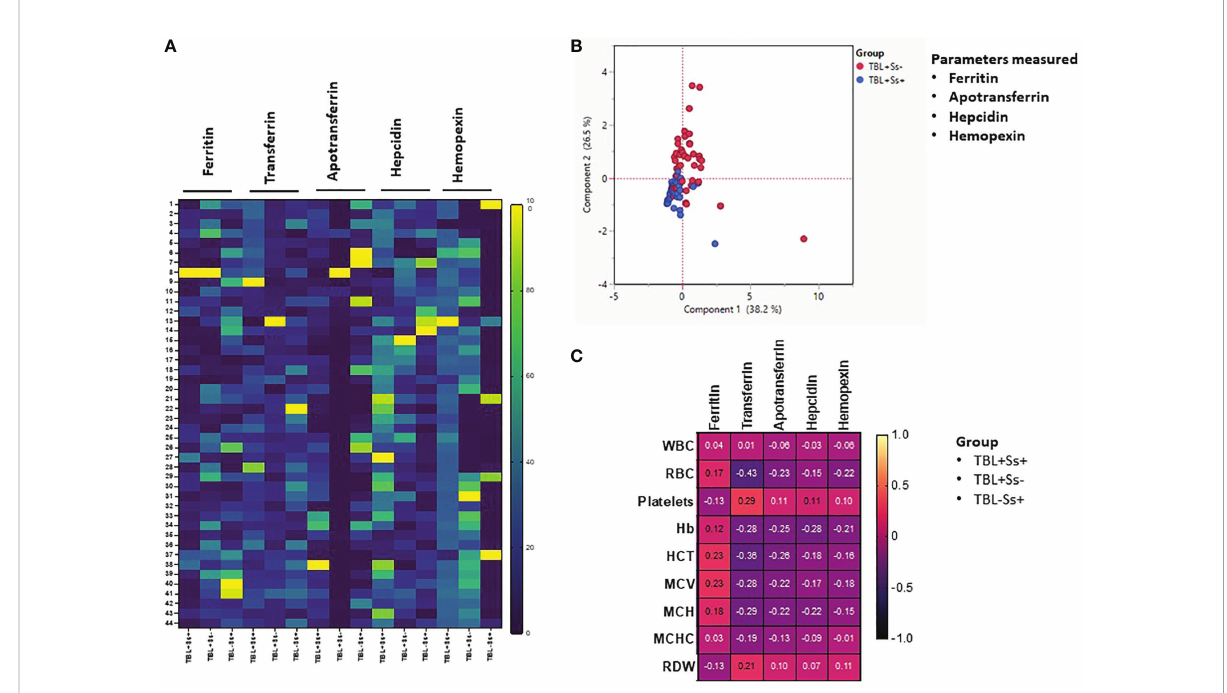
FIGURE 3 Heatmap, principal component analysis (PCA) and correlation analysis of iron status biomarkers. (A) Heatmap analysis of iron status (ferritin, TF, ApoT, hepcidin, hemopexin) biomarkers was performed between TBL+Ss+ (n=44), TBL+Ss- (n=44) and TBL-Ss+ (n=44) individuals. (B)